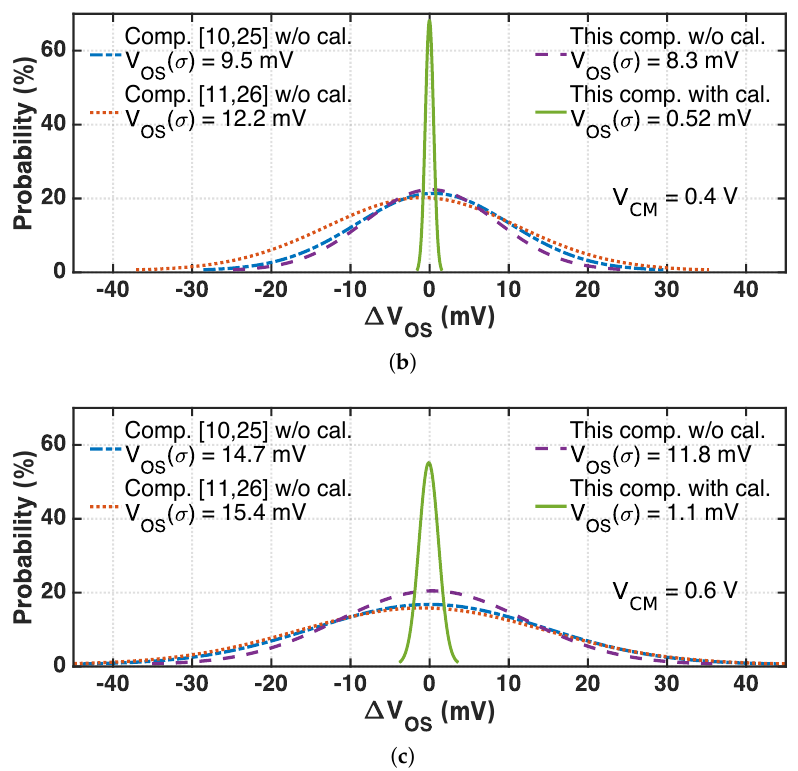
Figure 6. Simulated offset distribution for a V CM of 0.5 V ( a ), 0.4 V ( b ), and 0.6 V ( c ); for [10,11,25,26] and the proposed